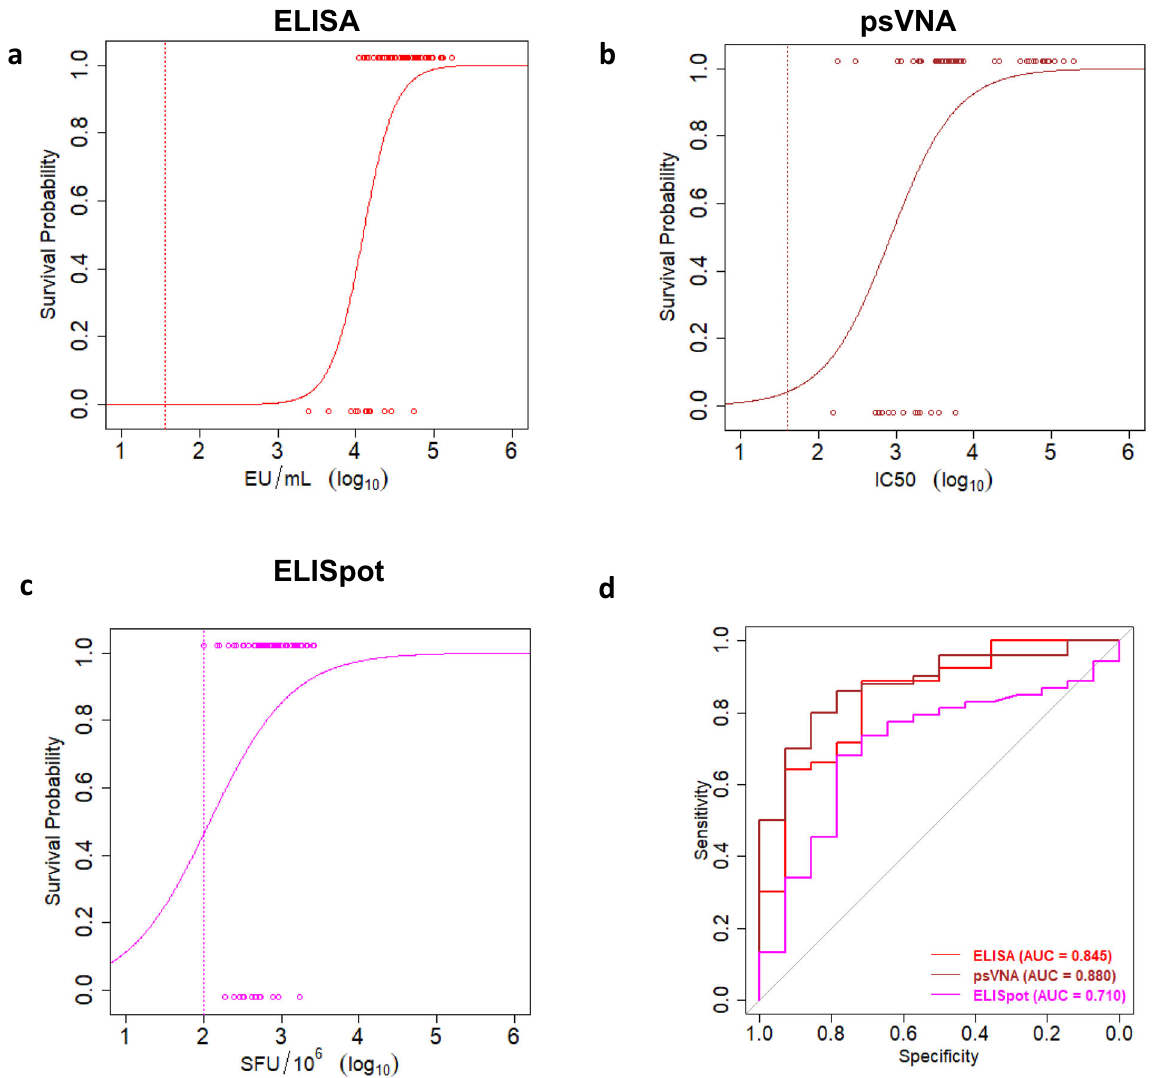
Fig. 3 Immunological correlates of protection in NHP. Graphs represent logistic regression models with immune parameters as predictors of survival after EBOV Kikwit challenge (100 pfu, IM) in cynomolgus monkeys for: a EBOV GP-binding antibody levels (ELISA, red), and b EBOV neutralizing antibodies (psVNA, brown). c EBOV GP-reactive T cells (IFN- γ ELISpot, purple). Individual immune response levels are identi fi ed with open circles and the associated survival as a binary variable with survival as 1 (top) and nonsurvival as 0 (bottom). Assay LODs are indicated by dotted lines. d ROC curves for sensitivity and speci fi city of GP-binding antibody levels (red), EBOV neutralizing antibodies (brown) and EBOV GP-reactive T cells (purple) in predicting NHP survival after challenge. ROC AUC are indicated in the panel. AUC area under the curve, ELISA enzyme-linked immunosorbent assay, IFN- γ ELISpot interferon-gamma enzyme-linked immunospot, EU ELISA units, IC 50 half-maximal inhibitory concentration, LOD limit of detection, psVNA pseudovirus neutralization assay, SFU spot-forming